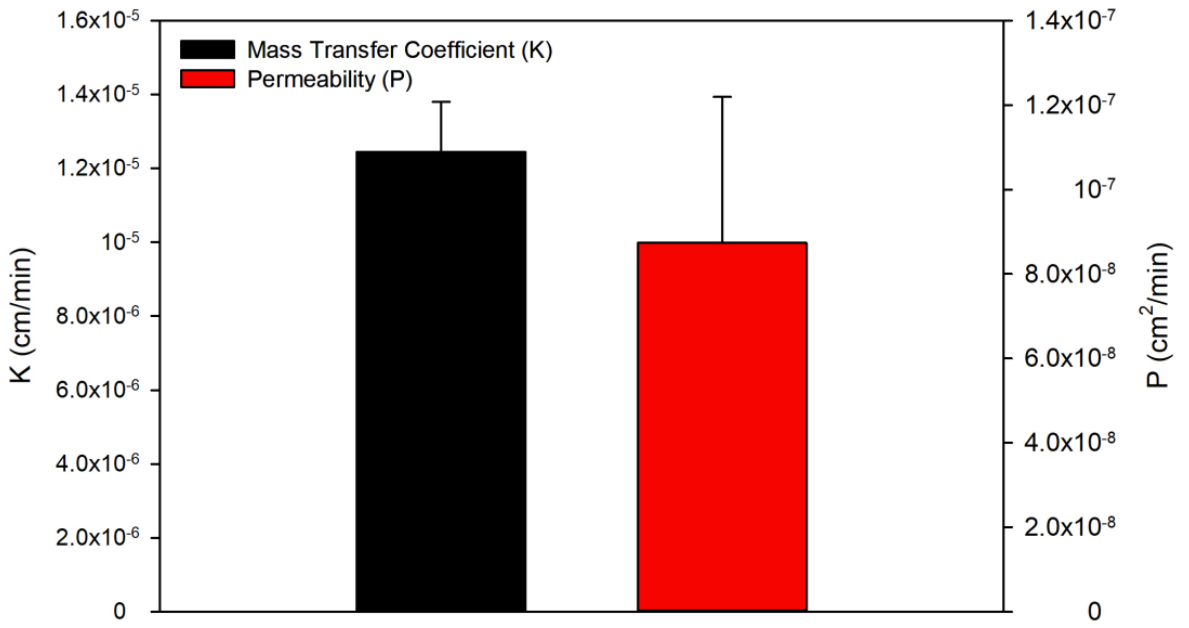
Figure 6. Comparison of the mass transfer coefficient (K) and capsule wall permeability (P). Error bars indicate the standard deviation.